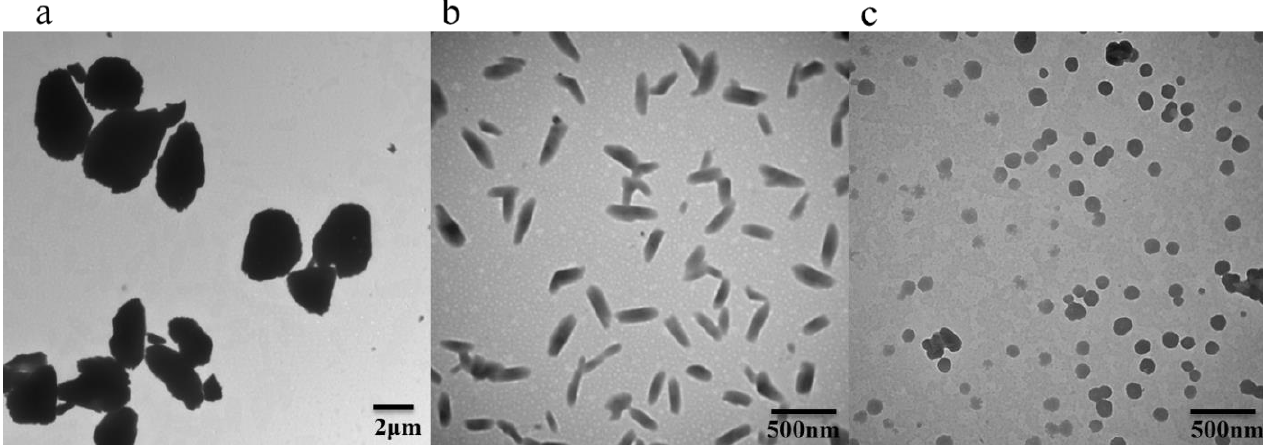
Figure 2. The transmission electron micrographs of nanocrystals: ( a ) MLX-NCs-A; ( b ) MLX-NCs-B; ( c ) MLX-NCs-C.